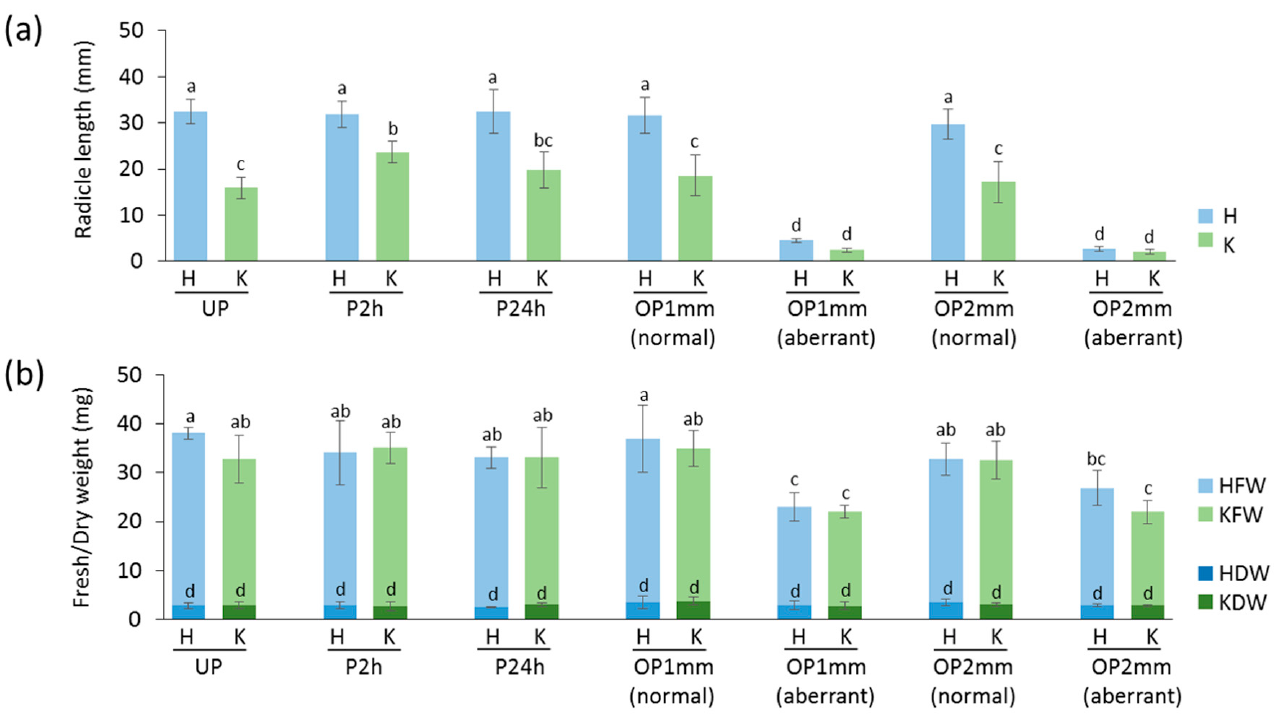
Figure 4. Biometrical analyses of 4-day-old M. truncatula seedlings as a result of imbibition and germination in presence/absence of kinetin and as a result of different hydropriming/hormopriming protocols and overpriming conditions. ( a ) Radicle length of ‘normal’ and ‘aberrant’ seedlings. ( b ) Fresh and dry biomass of ‘normal’ and ‘aberrant’ seedlings. UP, unprimed; P2h, 2 h-priming; P24h, 24 h-priming; OP1mm, overpriming with 1 mm radicle protrusion; OP2mm, overpriming with 2 mm radicle protrusion; H, water; K, kinetin; FW, fresh weight; DW, dry weight. Means with common superscript letters are not significantly different ( p < 0.05) as analyzed with two-way ANOVA and Tukey test.